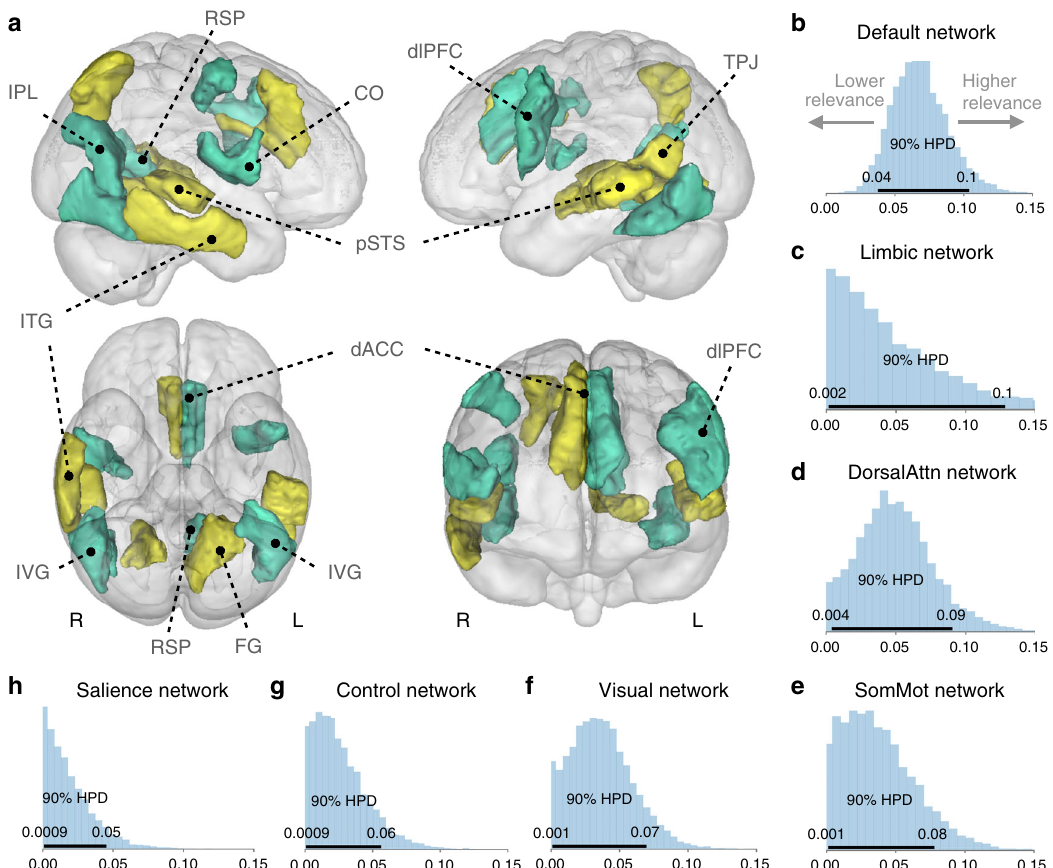
Fig. 1 Population associations between loneliness and brain structure. To provide a richer and more precise picture of variation, we purpose-designed a Bayesian hierarchical framework. The fully probabilistic modeling approach allowed jointly estimating varying effects in separate brain regions and spatially distributed networks of constituent brain regions. In rough analogy to ANOVA, the network de fi nitions could be viewed as “ factors ” and the region de fi nitions could be viewed as continuous factor “ levels ” . This analysis tactic enabled quantifying the extent to which spatially dispersed regional variation in gray matter volume can be better explained by coherent differences in major brain networks. a Contribution of each regional brain volume (thresholded according to 5 – 95% highest posterior density [HPD], black horizontal line in b – h ) to explain the difference between lonely and non-lonely individuals. Yellow/green = positive/negative volume association. b – h Shows the degree to which volume variation in each canonical network of regions reliably relates to loneliness. Posterior distributions for the variance parameter (sigma) of each brain network are ordered from the most important (default network) to the least explanatory (salience network). CO central operculum, ITG inferior temporal gyrus, pSTS posterior superior temporal sulcus, TPJ temporoparietal junction, IPL inferior parietal lobe, dACC dorsal anterior cingulate cortex, dlPFC dorsolateral prefrontal cortex, RSP retrosplenial cortex, FG fusiform gyrus, IVG inferior visual gyrus, L/R denotes left/right hemisphere. The shown Bayesian model was fi tted once to our whole UKB sample, but brain-loneliness associations held up to cross-validated out-of-sample testing in structural MRI (Supplementary Fig. 11). Source data are provided as a Source Data fi limbic network (sigma = 0.06, HPD = 0.01/0.14), dorsal attention hierarchical approach was used to focus on variation in gray matter network (sigma = 0.05, HPD = 0.01/0.09), somatomotor network volume in the 100 individual atlas regions (Fig. 1). Positive region- (sigma = 0.04, HPD = 0.01/0.08), visual network (sigma = 0.04, level volume associations with loneliness emerged in the posterior HPD = 0.01/0.07), frontoparietal control network (sigma = 0.03, superior temporal sulcus on the left (posterior mean = 0.14, 5 – 95% HPD = 0.01/0.06), and, relatively least explanatory, the salience HPD = 0.01/0.27) and right (mean = 0.27, HPD = 0.10/0.44), the network (sigma = 0.02, HPD = 0.01/0.05). Considering the con- left temporoparietal junction (mean = 0.17, HPD = 0.05/0.28), as fi dence estimates of overall network relevances (i.e., 5 – 95% HPD well as the left fusiform gyrus (posterior mean = 0.13, HPD = 0.01/ 0.26), right inferior temporal gyrus (mean = 0.31, HPD = 0.16/0.46), right posterior parietal lobe (mean = 0.15, HPD = 0.03/0.26), and right dorsal anterior cingulate cortex (mean = 0.14, HPD = 0.01/ 0.28). In contrast, the left dorsal anterior cingulate cortex showed a negative region-level volume association (mean = − 0.14, HPD = − 0.27/ − 0.01) in addition to the dorsolateral prefrontal cortex on the left (mean = − 0.12, HPD = − 0.24/ − 0.01) and right (mean = − 0.12, HPD = − 0.22/ − 0.02), the right central operculum (mean = − 0.16, HPD = − 0.29/ − 0.05) and the right inferior parietal lobule (mean = − 0.27, HPD = − 0.42/ − 0.14), left retrosplenial cortex (mean = − 0.19, HPD = − 0.30/ − 0.08) as well as the inferior visual